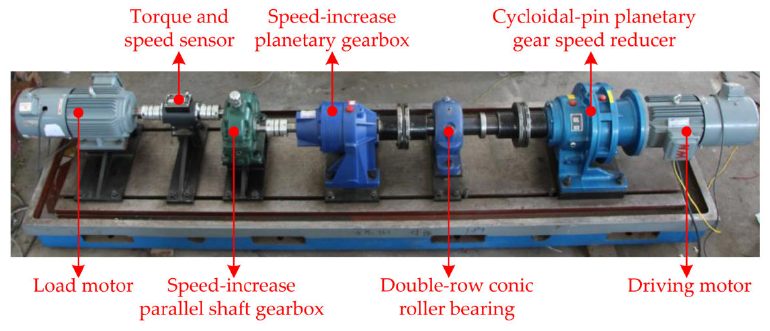
Figure 11. Gearbox test bench.